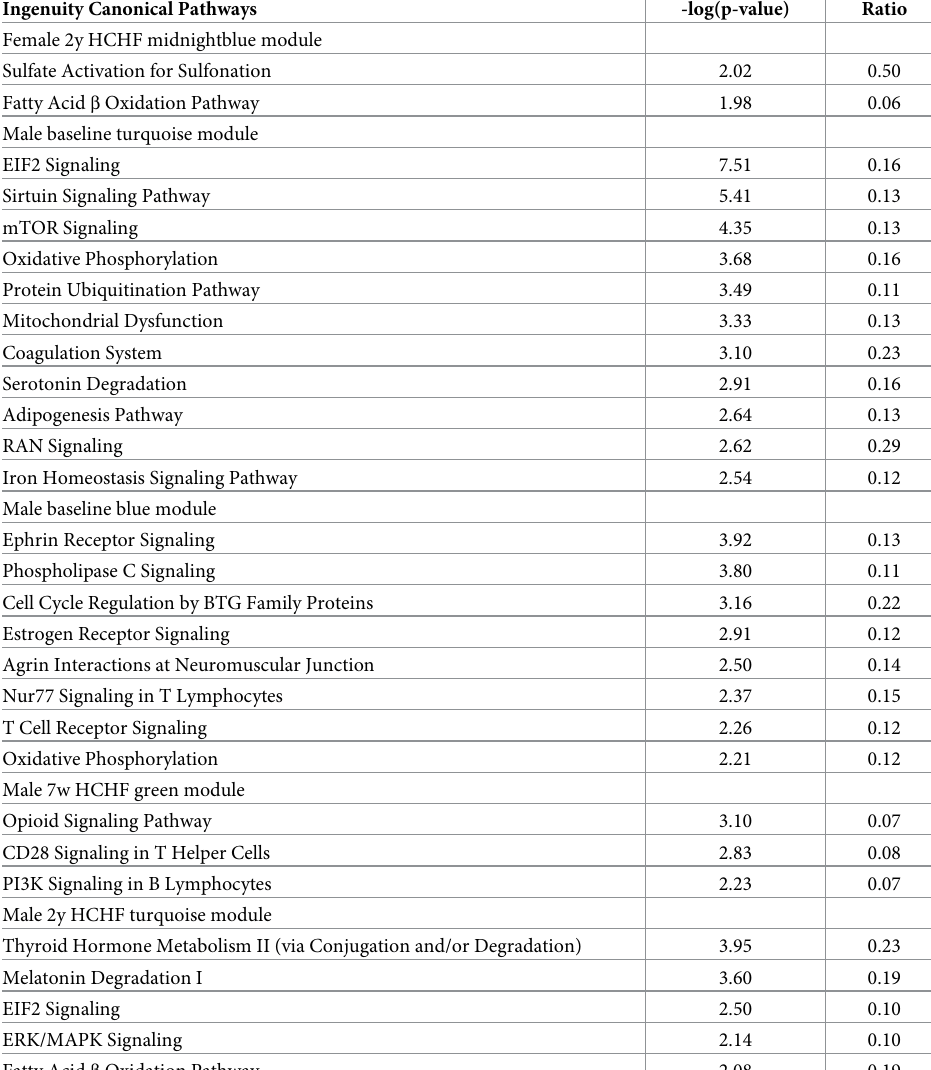
In females from the 2y timepoint, midnightblue module genes were enriched in 2 pathways: sul- phate activation for sulfonation and fatty acid β oxidation (Table 3, Fig 2, S2A Table). The EOP gene for fatty acid β oxidation pathway included solute carrier family 27 member 5 ( SLC27A5/ FATP5 ) and hydroxyacyl-CoA dehydrogenase trifunctional multienzyme complex subunit beta ( HADHB ) genes which are upregulated with lesions at 2yr timepoint. Causal network analysis revealed TP53 with 17 target genes positively correlated with lesions (Table 4 and S2A Table). Pathway and network analysis of module genes correlated lesions in males In males at baseline, the turquoise module genes were enriched in 11 pathways and the blue module genes in 8 pathways. Among these pathways were EIF2 signaling (Fig 3), oxidative Table 3. Significant pathways passing end-of-pathway